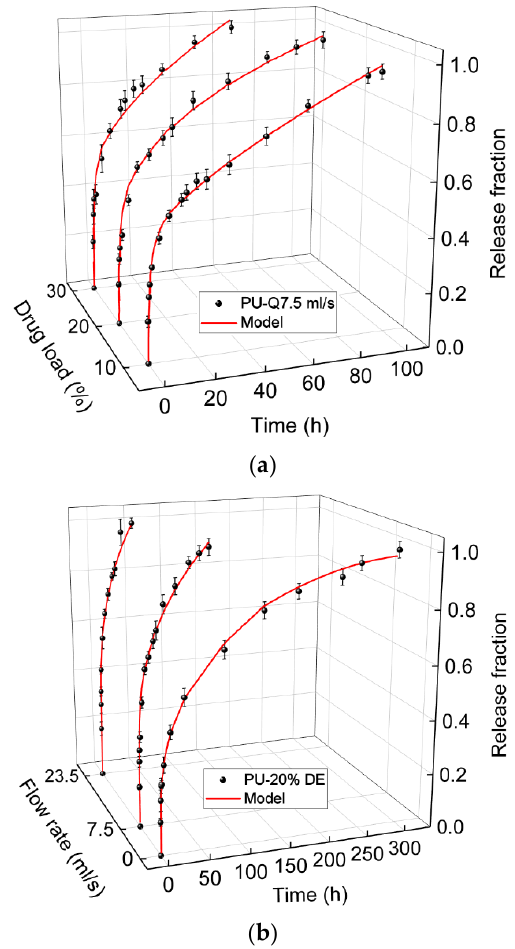
Figure 4. Comparing the calculated values with the Equation (16) and the experimental data of diclofenac release from the polyurethane (PU) matrix, ( a ) for three different drug concentrations; 10%, 20%, and 30% at the flow rate of 7.5 mL/s ( b ) and for the PU with 20% of drug at the flow rates of 0, 7.5, and 23.5 mL/s. Table 1. Values related to the percentage of the contribution of the mechanisms associated in the drug release and affecting release kinetic (PU-10%DE-Q7.5 mL/s: polyurethane sample with 10% diclofenac epolamine released at the flow rate of 7.5 mL/s).